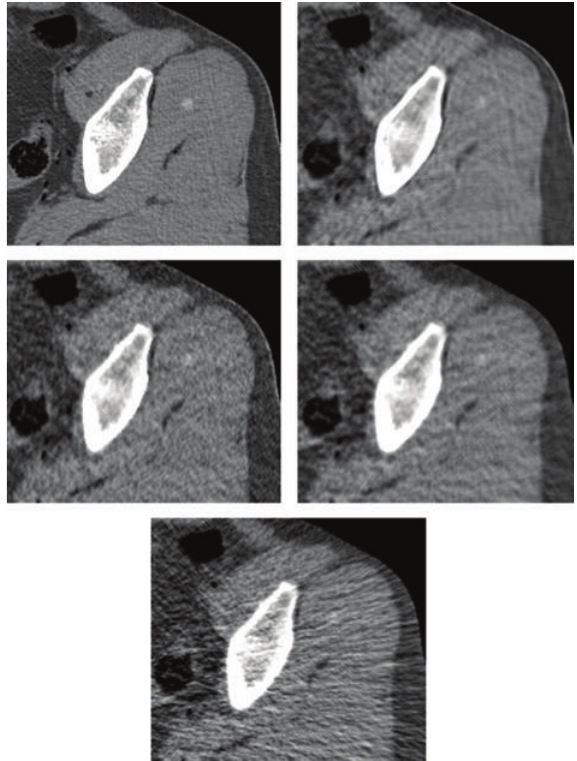
Figure 17: Detectability test for a small inserted lesion. Upper to lower rows, right to left: reference image, our method, PWLS, ATM, and FBP images. The HU window is [−220,350]